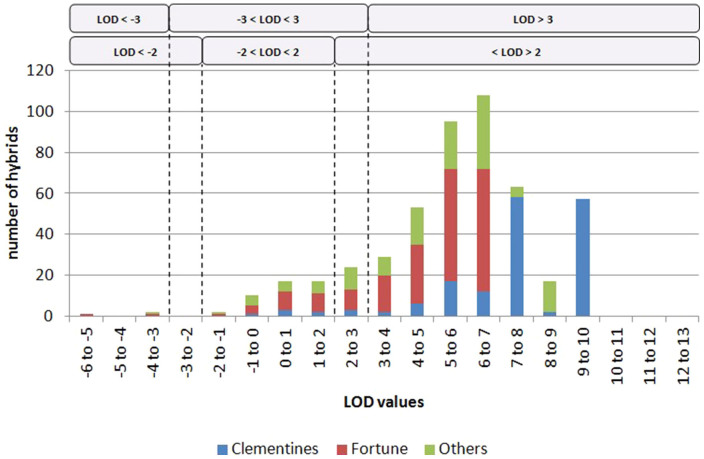
Frequency histogram of LOD values obtained for each individual 2n gamete, indicating those arising from clementines, ‘Fortune’ mandarin and other mandarins analysed in this study.